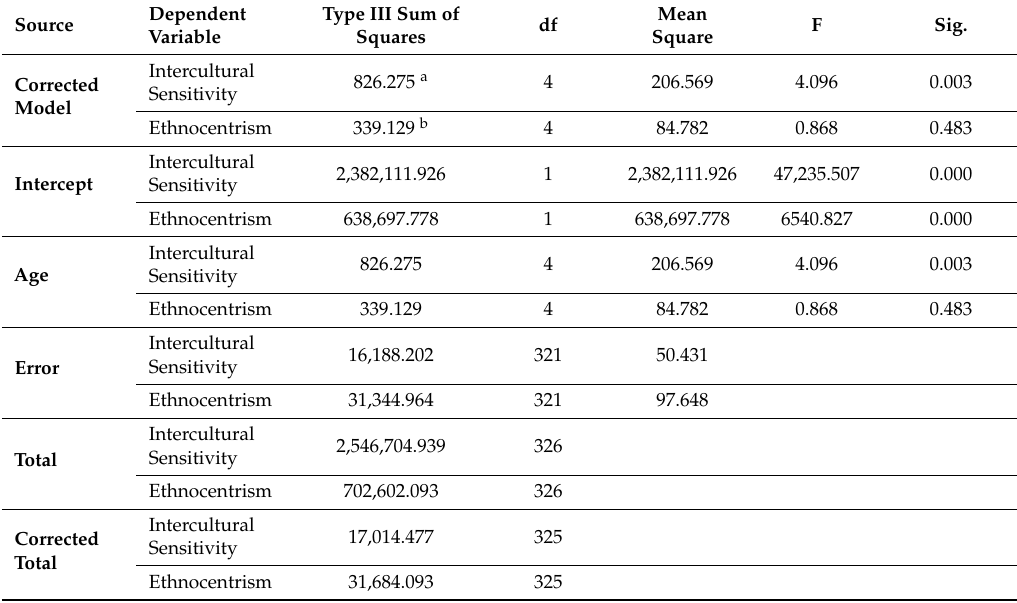
Table 7. Interaction between Intercultural Sensitivity and Ethnocentrism and the ages of theology